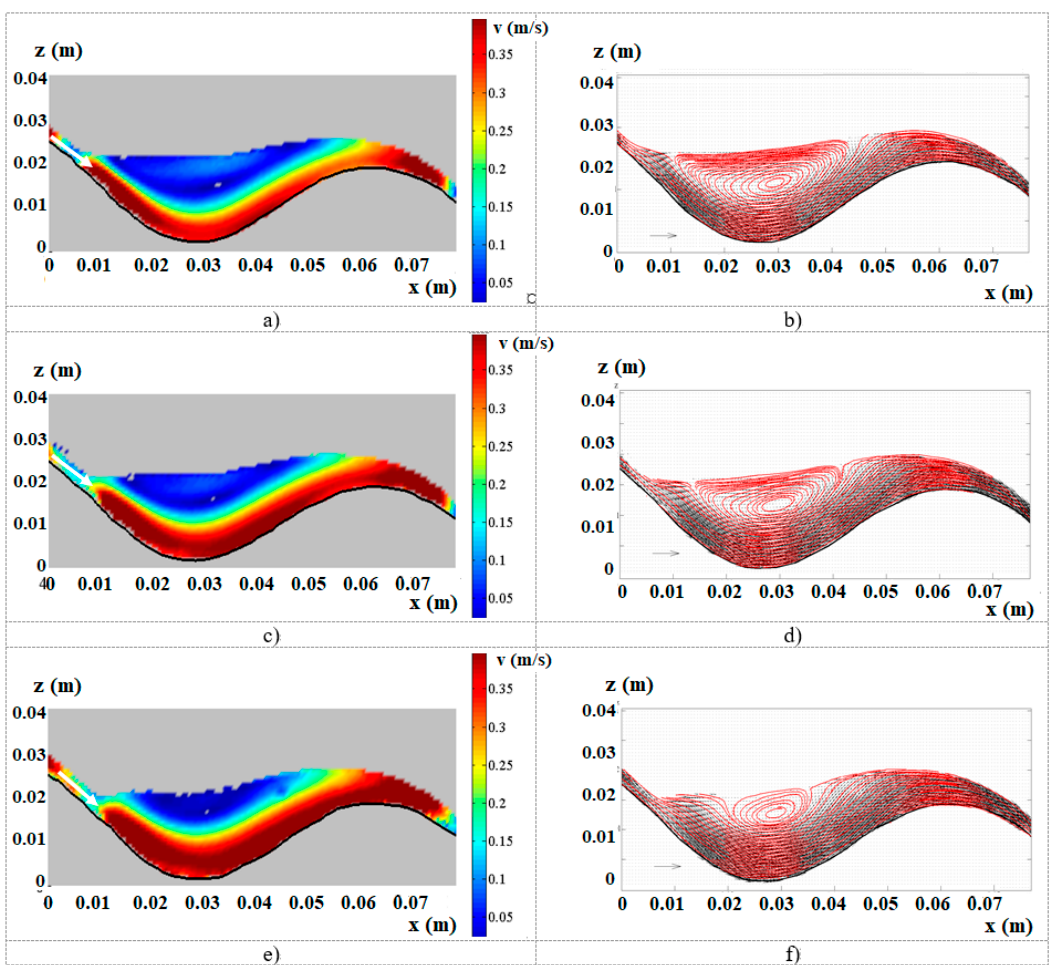
Figure 4. Experimental colormap results for 6° slope and flow rate per unit width ( a ) q 1 , ( b ) q 2 , and ( c ) q 3 . Streamlines at flow rate per unit width ( d ) q 1 , ( e ) q 2 , and ( f ) q 3.